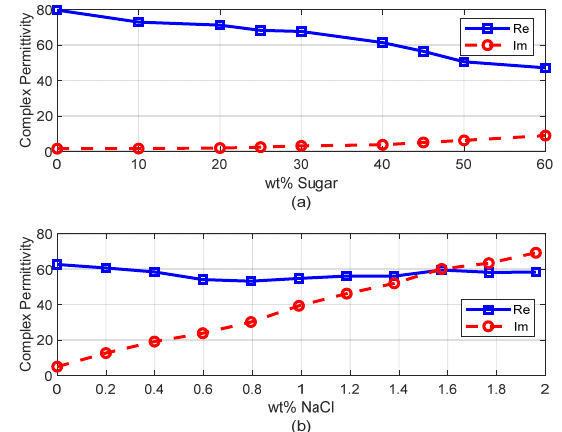
Figure 6. ( a ) Measured dielectric permittivity (real and imaginary part) as a function of sugar mass fraction at 406 MHz, and ( b ) measured dielectric permittivity (real and imaginary part) as a function of NaCl mass fraction and 45% sugar at 406 MHz.